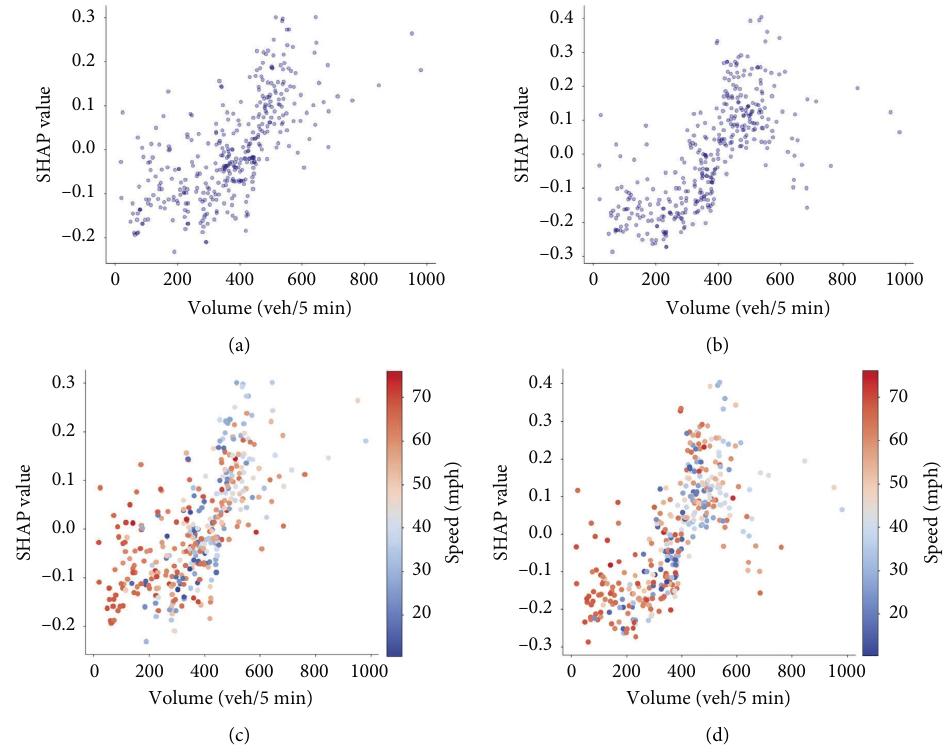
Figure 5: SHAP local dependence plots of volume. (a) Main efects of volume on the time gap. (b) Main efects of volume on the distance gap. (c) Interaction efects between volume and speed on the time gap. (d) Interaction efects between volume and speed on the distance